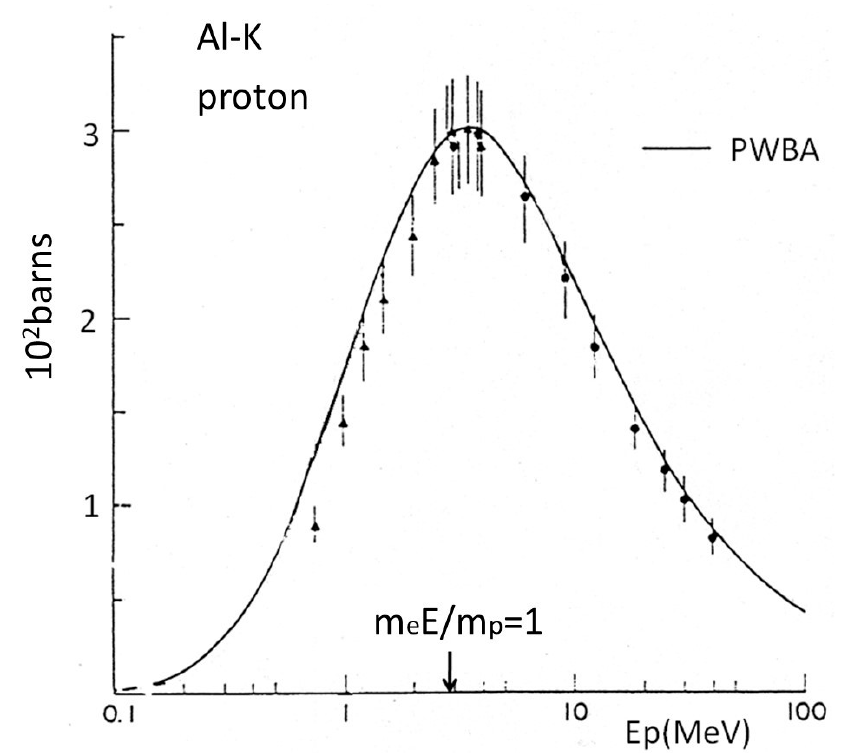
Figure 2. K-shell ionization cross sections of Al as a function of proton energy.